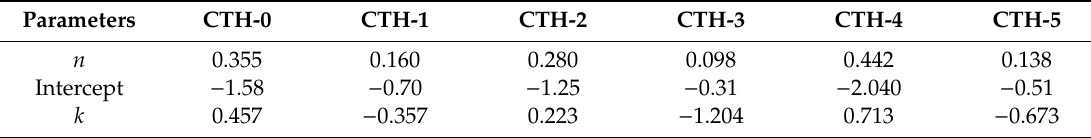
Table 4. Di ff usion parameters of di ff erent CS / PAH films.